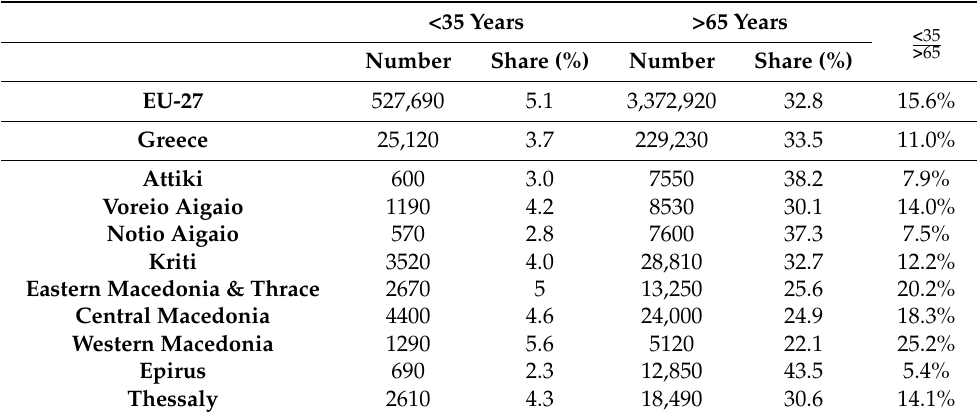
Table 1. Farmers’ age structure of EU-27, Greece and Greek NUTS-II (year